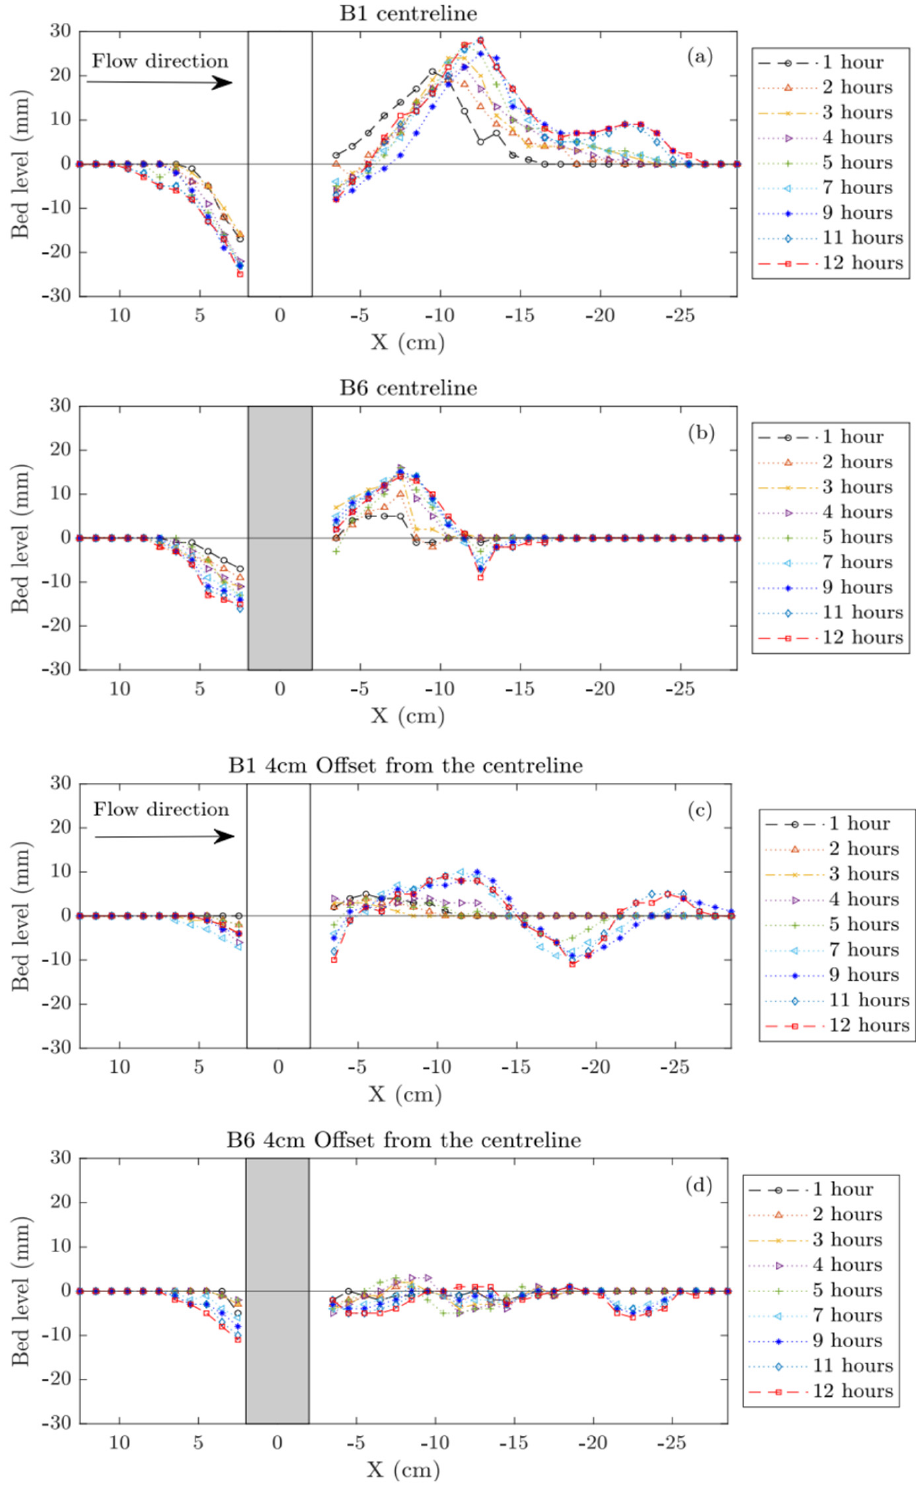
Figure 3. Longitudinal section of the bed development over time from 1 h to 12 h where ( a , b ) is along the channel and cylinder centerline (Y = 0) and ( c , d ) are one-cylinder diameter lateral offset from the centerline (Y = 40 mm) for the experiment with sediment d 50 = 0.86 mm, where B1 is the unprotected pier and B6 is the protected pier with cable-pier diameter ratio b c /b = 0.25. Flow is from left to